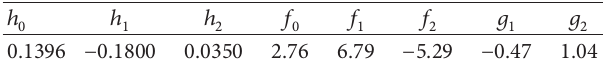
Figure 2: The trace anomaly normalized by 𝑇 4 with the parametrization of (7) using the parameters in Table 1 for 𝑛 𝑓 = 2+1 [13] (color online). Table 1: Parameters of the function in (7) describing the trace anomaly for 𝑛 𝑓 = 2 + 1 [13].